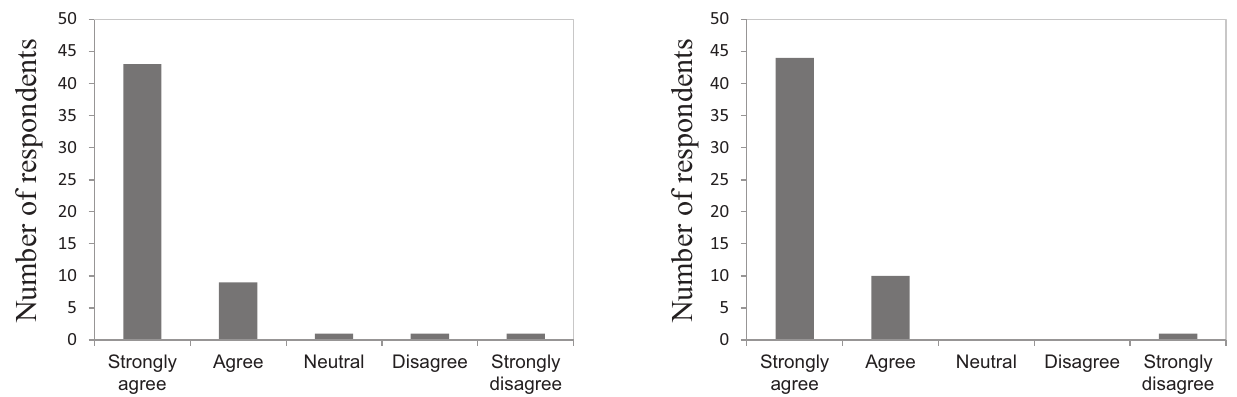
Figure 1. ( A ) Measurement of the efficacy of the session based on correctly answered questions in pre and post quizzes. Note that the combination of group numbers and corresponding numbers of correctly answered questions is different from the actual